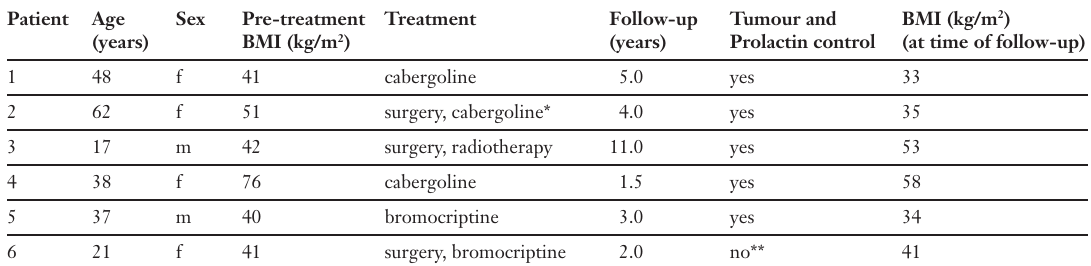
Age and BMI (mean standard deviation) of patients present- ing with pituitary adenoma and BMI group means ad- justed for age and sex.